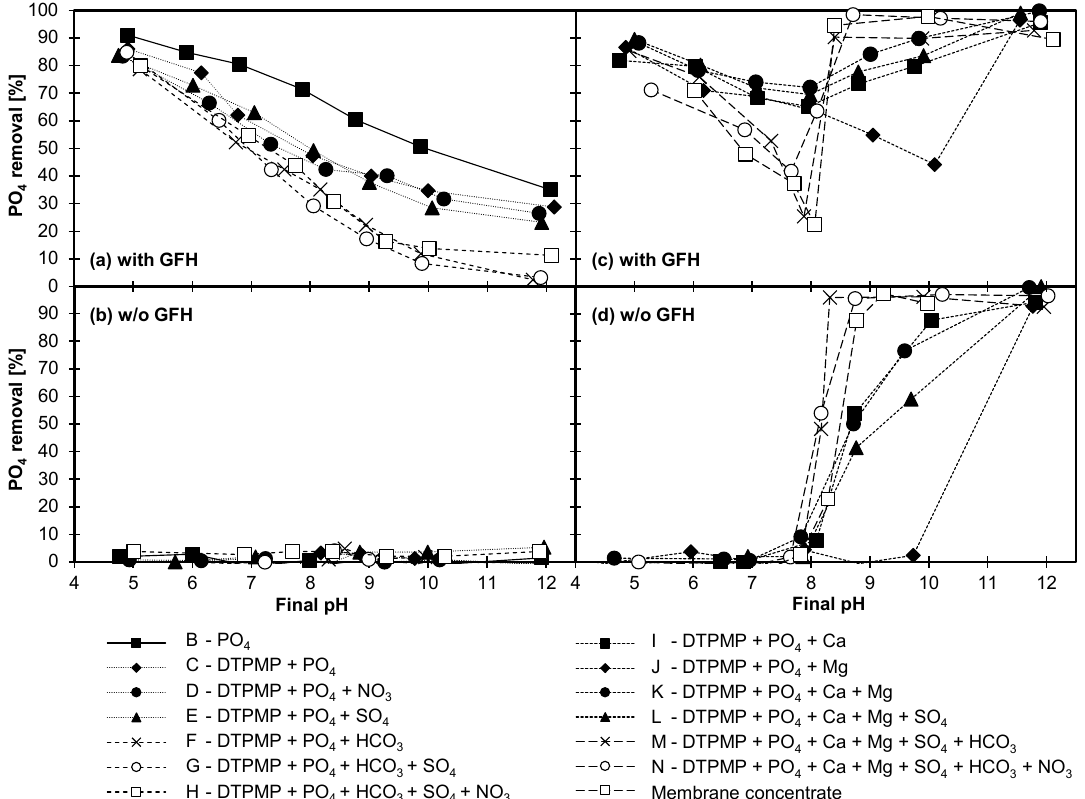
Figure 5. Phosphate removal from synthetic replicas and real membrane concentrate (T = 20 °C; t c = 7 d; initial concentration see chapter 2.3; 0.1 g GFH/L and without GFH). ( a ) solutions B-H with GFH, ( b ) solutions B-H without GFH, ( c ) solutions I-N and membrane concentrate with GFH, ( d ) solutions I-N and membrane concentrate without GFH.